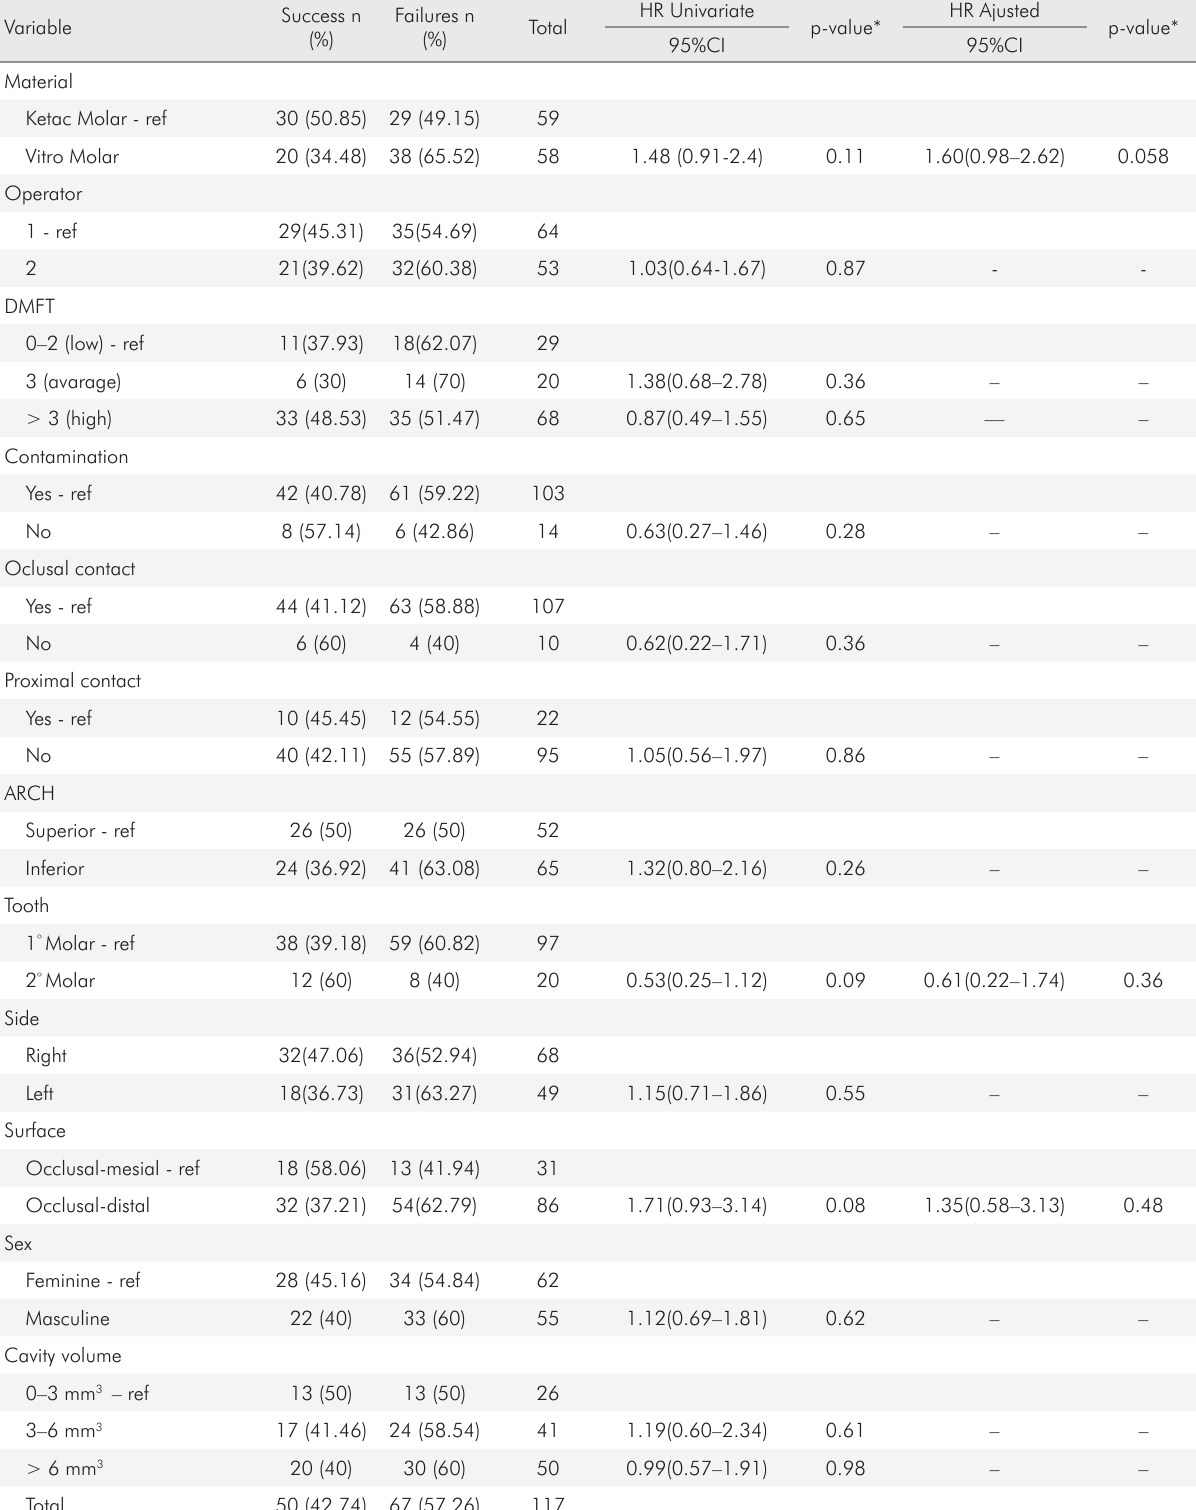
Table 2. Descriptive univariated and adjusted Cox regression analysis between failures in occlusoproximal restorations and associated